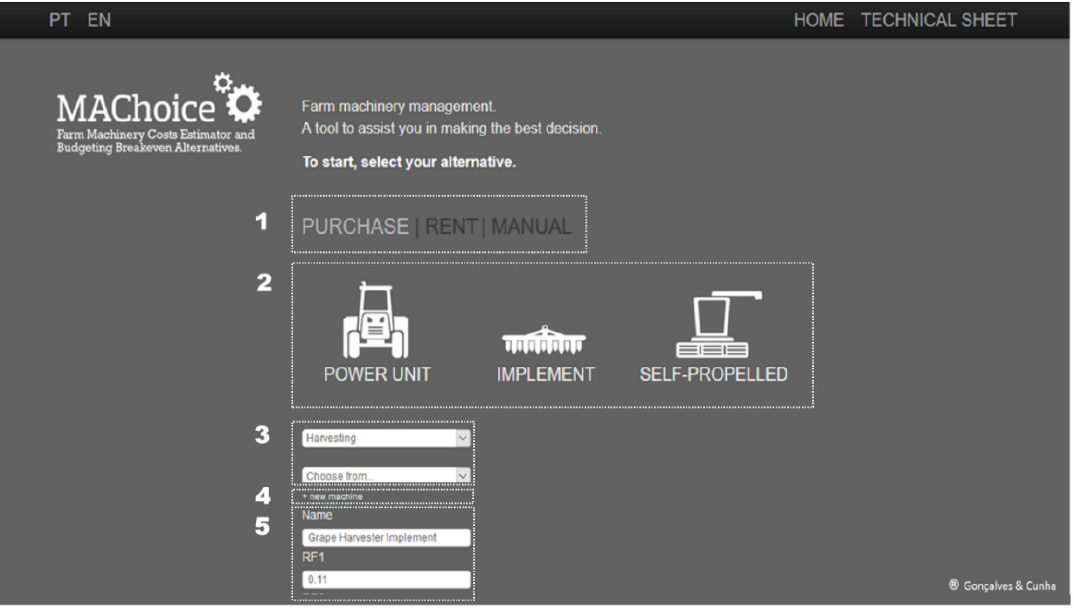
Figure 1: MACHoice’s screen-shot of user interface with example explaining the path to add a new machine (e.g. Grape Harvester implement) for costs